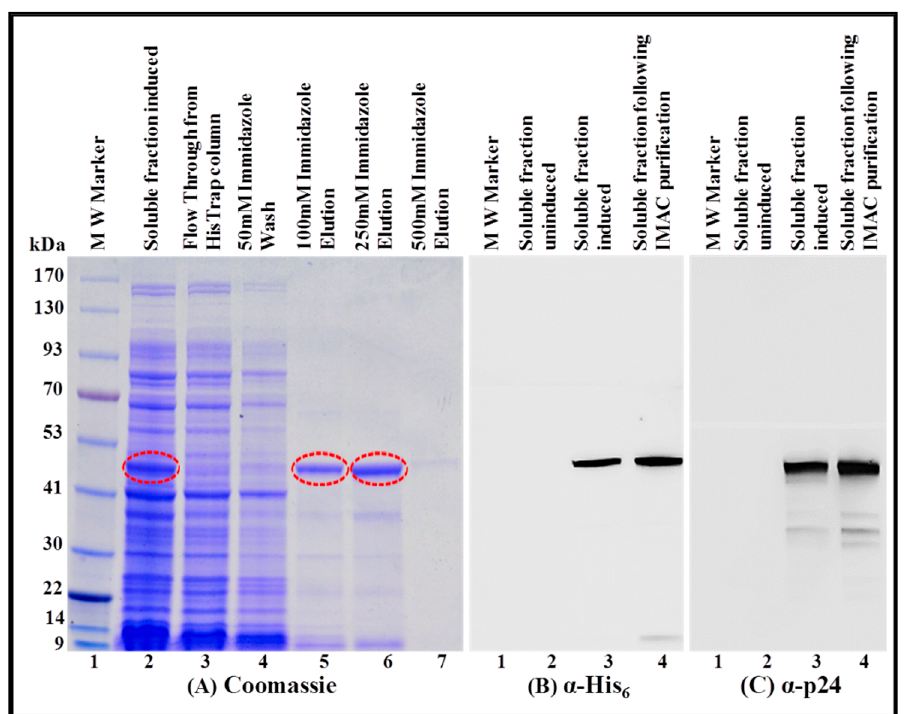
Figure 7. Purification of the FIV recombinant Pr50 Gag -His 6 -tag protein from soluble fractions by immobilized metal affinity chromatography (IMAC) and its western blot analysis. ( A ) Coomassie Brilliant Blue-stained SDS-polyacrylamide gel on which bacterial soluble fractions containing FIV Pr50 Gag -His 6 -tag fusion protein was electrophoresed before and after IMAC purification using different concentrations of immidazole. Western blot analyses on the same soluble fractions (before and after IMAC purification) using α -His 6 ( B ) and FIV α -p24 ( C ) monoclonal antibodies, respectively, using equal amounts of protein.